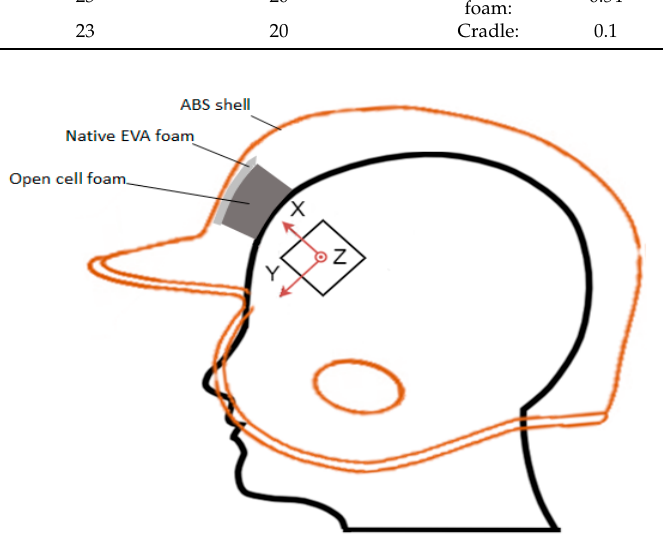
Figure 2. Schematic of the headform within the helmet showing position of accelerometer within headform and foam layers (z-axis coming out of the page).